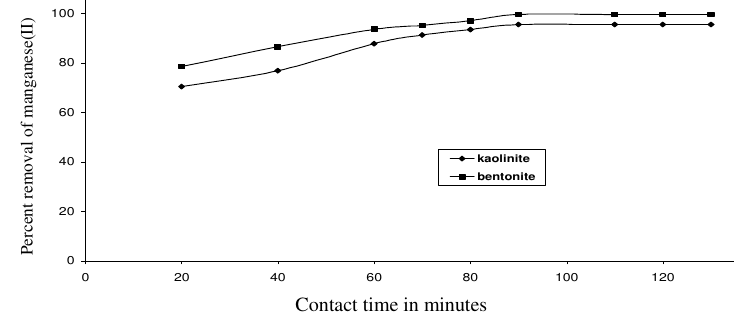
Figure 5. Effect of contact time on percent removal of manganese(II)